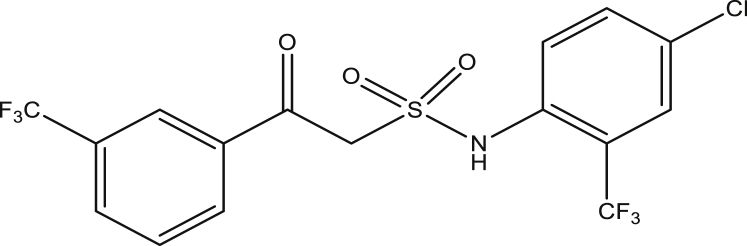
Chosen scaffold [compound 9 (pEC50 =0.858537)].